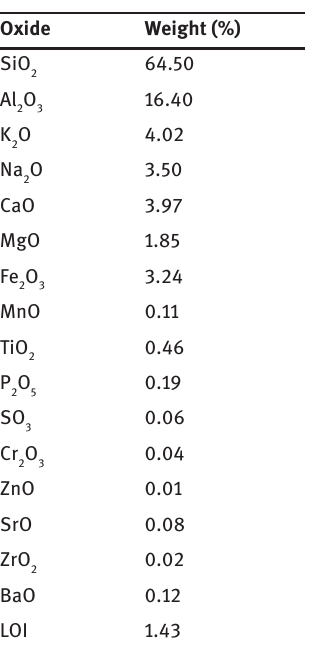
Table 1: Chemical composition of Sille stone.